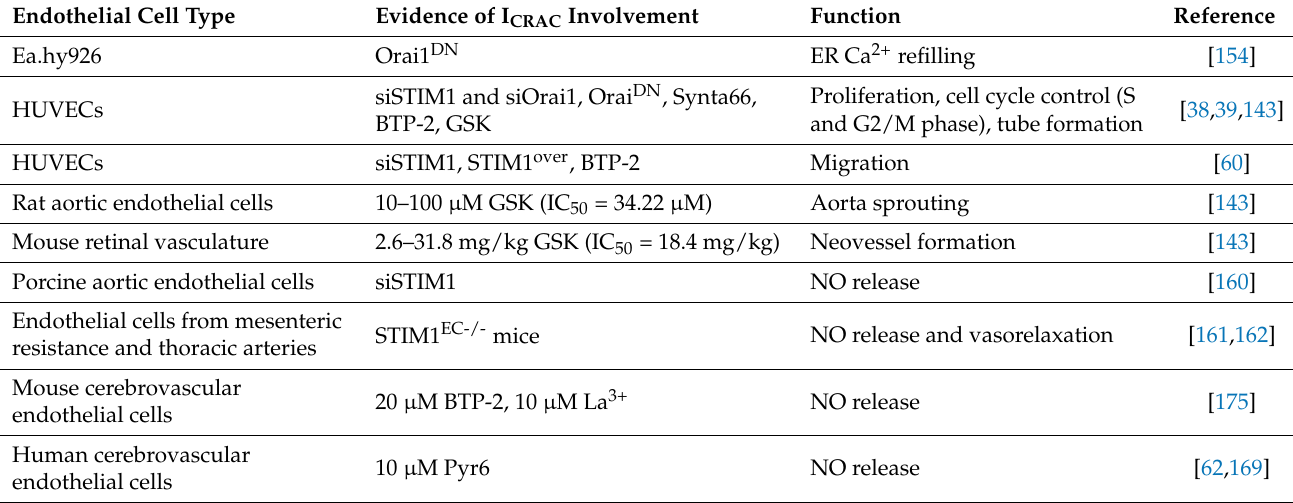
Table 3. Endothelial functions modulated by the I CRAC